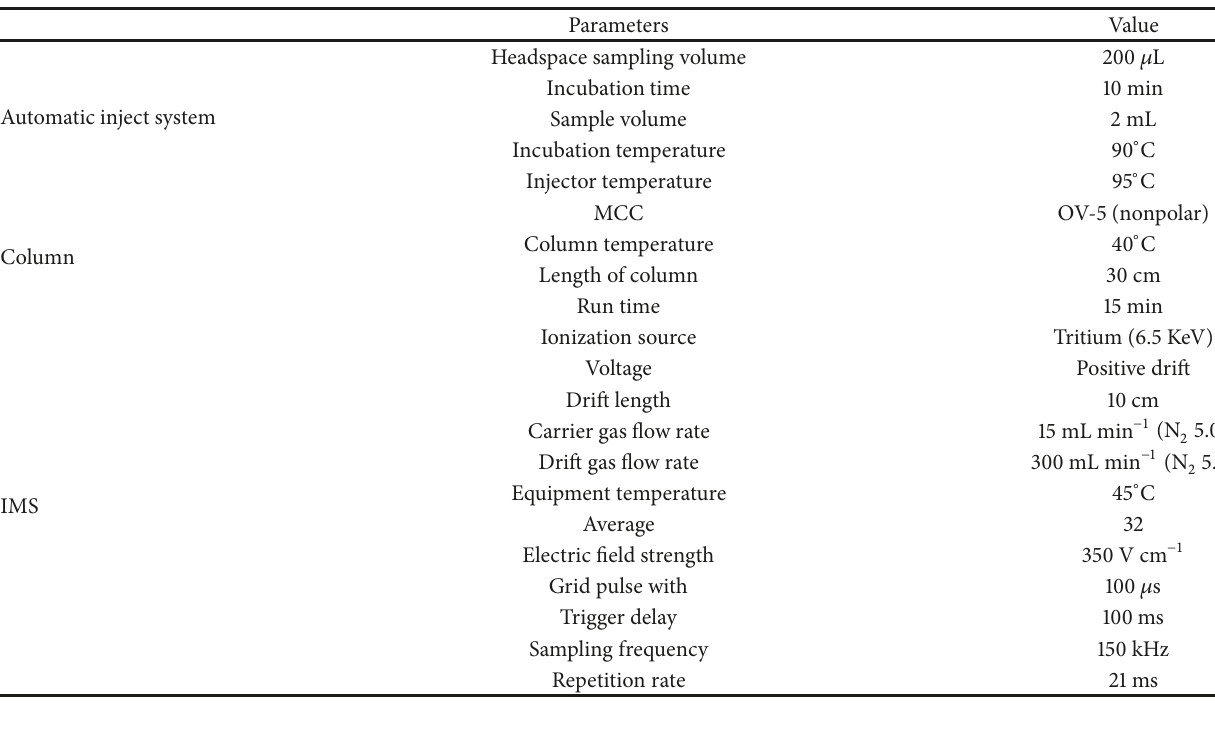
Table 1: Experimental conditions for GC-IMS analyses.